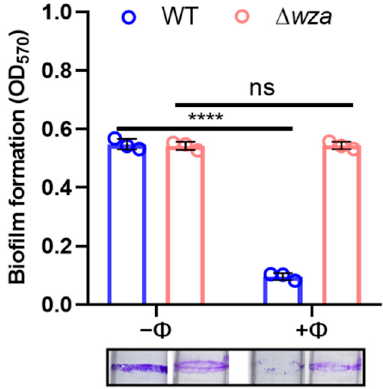
Figure 4. Phage SRD2021 lysis efficiency on formed biofilms of wildtype and ∆ wza mutant of CRKP